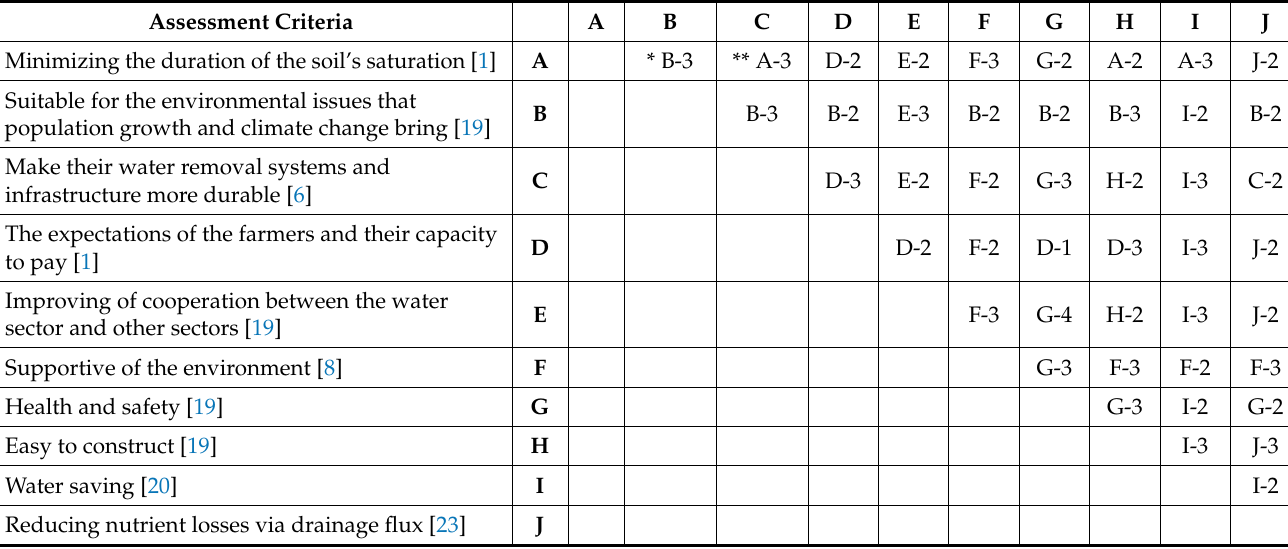
Table 2. Assessment Criteria Weighting